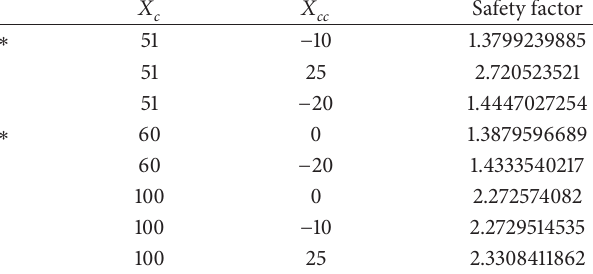
Table 3: Crossover